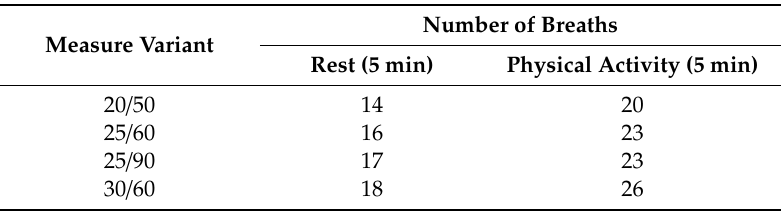
Table 4. Average number of breaths per